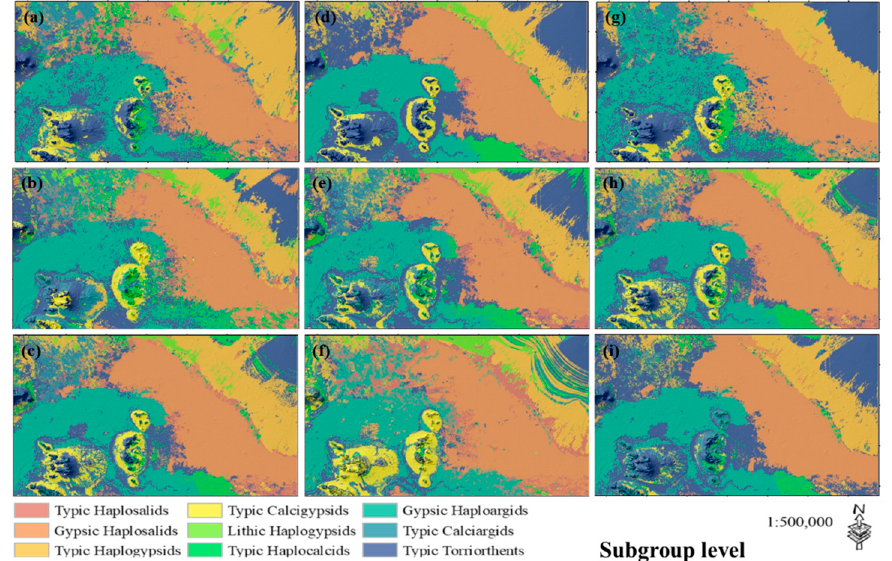
Figure 4. The spatial distribution of soil classes at Subgroup level using different spatial models: Multinomial Logistic Regression ( a ); Artificial Neural Networks ( b ); Support Vector Machines ( c ); Decision Tree ( d ); Random Forest ( e ); Bayesian Networks ( f ); Sparse Multinomial Logistic Regression ( g ); Ensemble.1 ( h ) and Ensemble.2 ( i ).